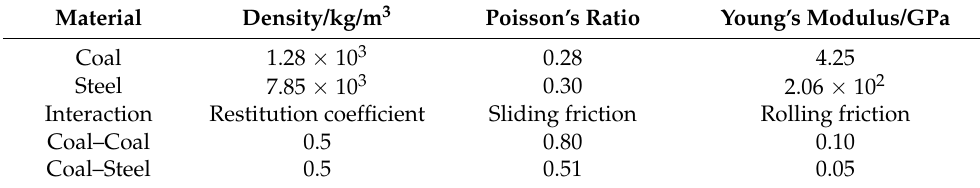
Table 1. Material and contact parameters in the DEM.